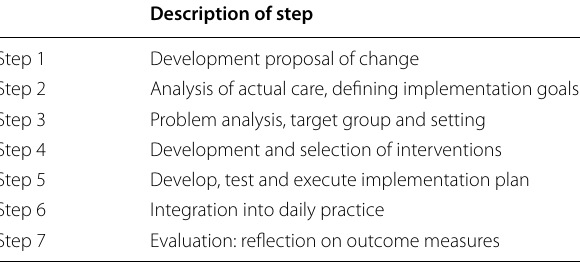
Table 1 Different steps used during implementation